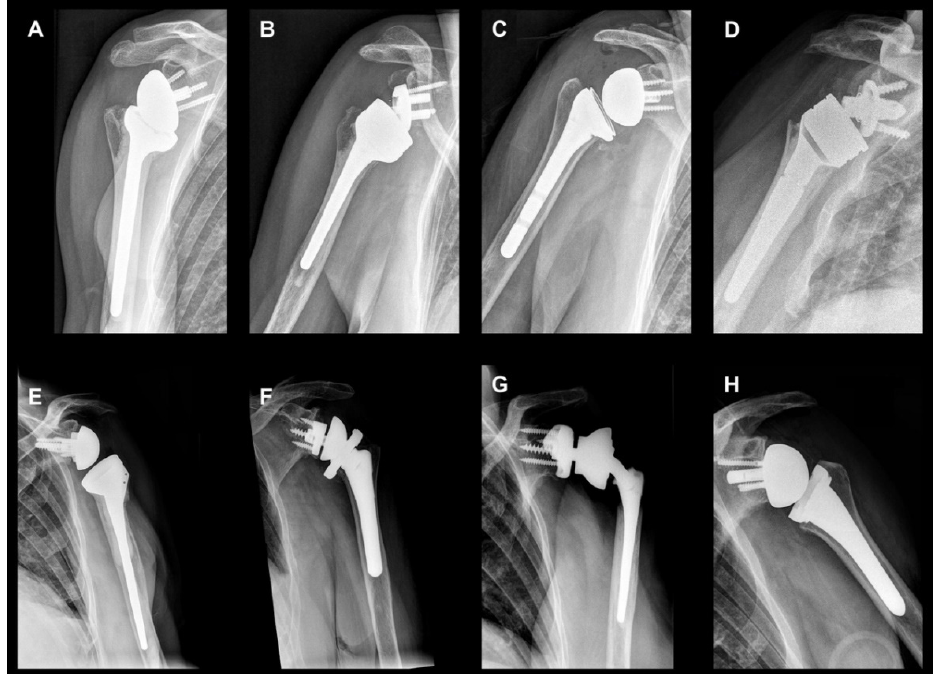
Figure 2. Standard anteroposterior radiographs of the shoulder after reverse total shoulder implan- tation with different designs and implantation techniques: ( A ) Right shoulder, cemented Delta XTEND™ (DePuy Synthes, Raynham, MA, USA); ( B ) Right shoulder, cemented Affinis Inverse (Mathys, Bettlach, Switzerland); ( C ) Right shoulder, uncemented HUMELOCK™ Reverse (FX Solu- tions, Viriat, France); ( D ) Right shoulder, cemented Lima SMR-system (Lima, Villanova, San Daniele del Friuli, Italy); ( E ) Left shoulder, cemented Tornier AEQUALIS™ ADJUSTABLE REVERSED (Wright, Memphis, TN, USA); ( F ) Left shoulder, uncemented Comprehensive ® Reverse Shoulder System (Zimmer Biomet, Warsaw, IN, USA); ( G ) Left shoulder, cemented custom made reverse total shoulder arthroplasty (Zimmer Biomet, Warsaw, IN, USA); ( H ) Left shoulder, uncemented MyShoulder ® (Medacta, Castel San Pietro, Switzerland).